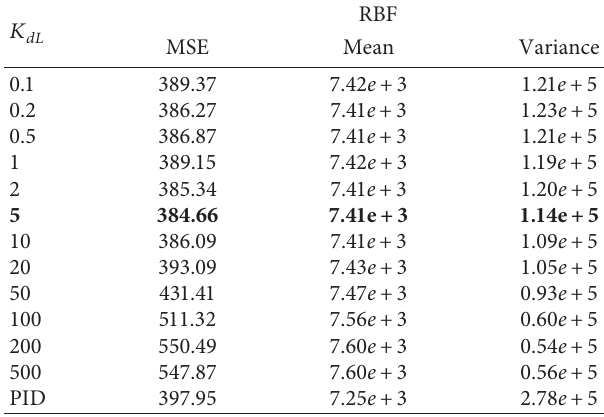
Table 5: Variation of MSE, output power mean, and variance with _ P . err MAX